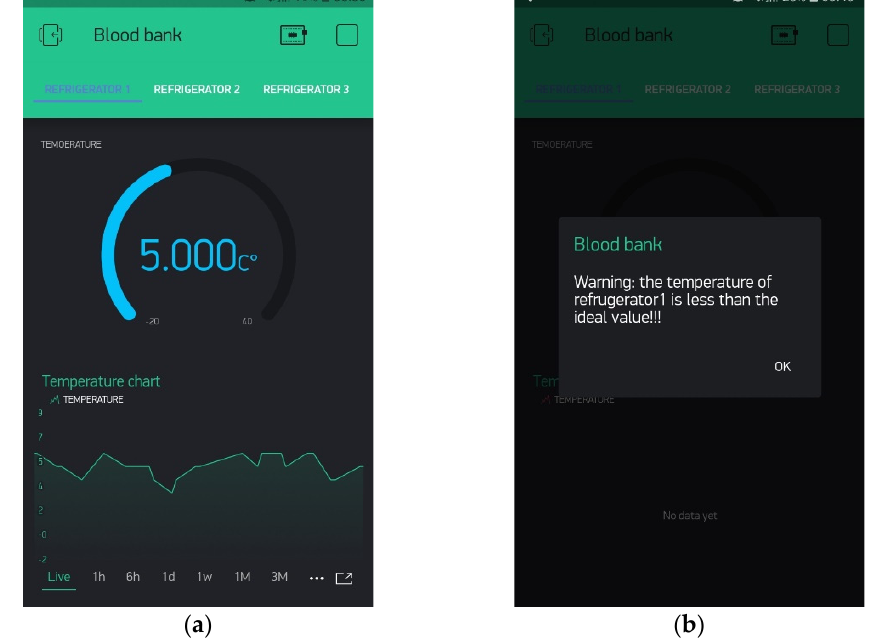
Figure 12. The monitoring process: ( a ) shows the temperature degree within an acceptable range; ( b ) shows the warning message if the temperature is outside of the acceptable